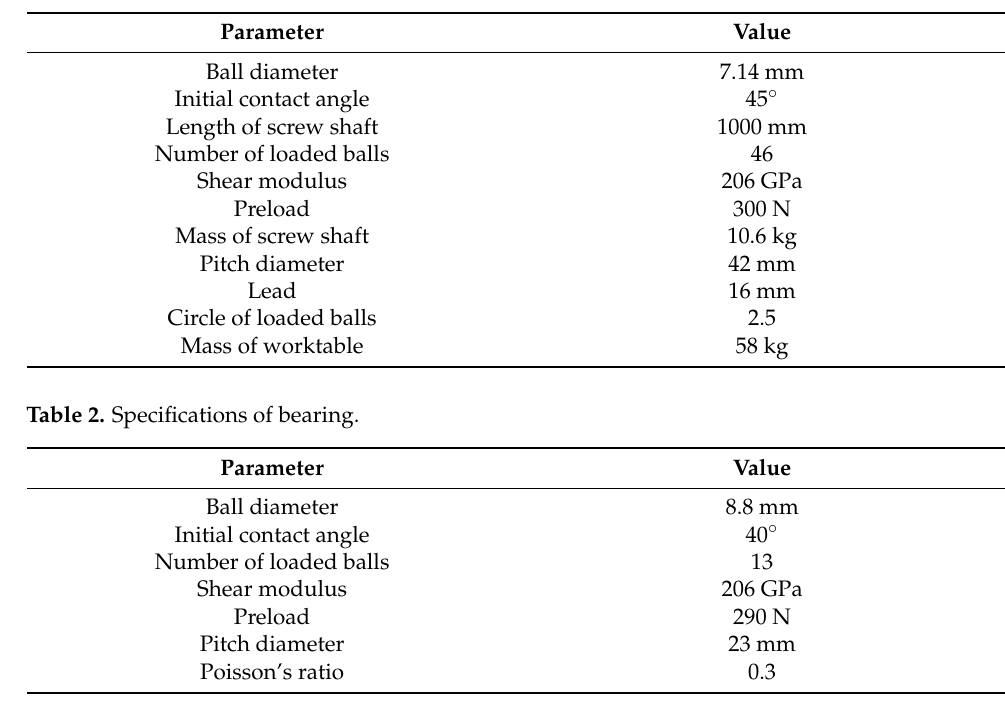
Table 1. Specifications of ball screw.